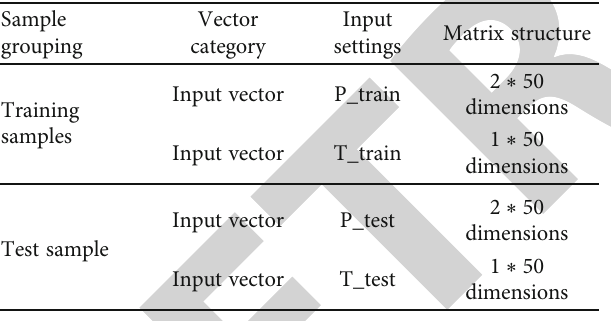
Table 3: Neural network complex model vector setting content.